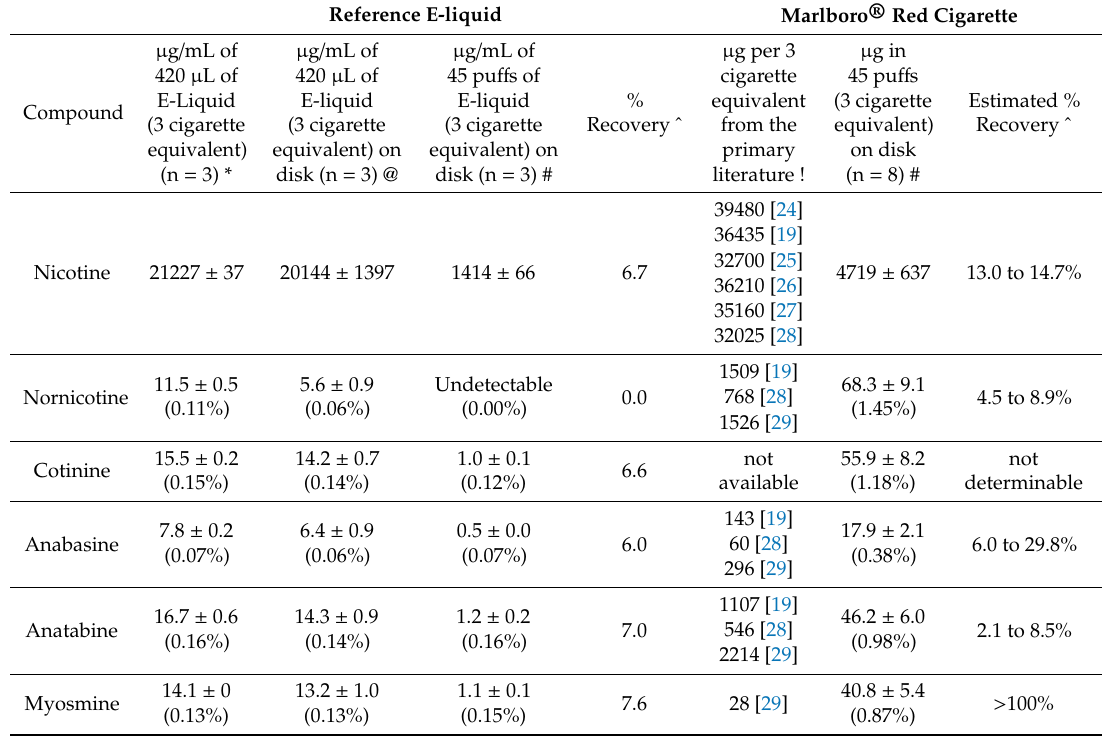
Table 4. Nicotine and nicotine-related alkaloids generated from E-liquid aerosol and tobacco smoke. Reference